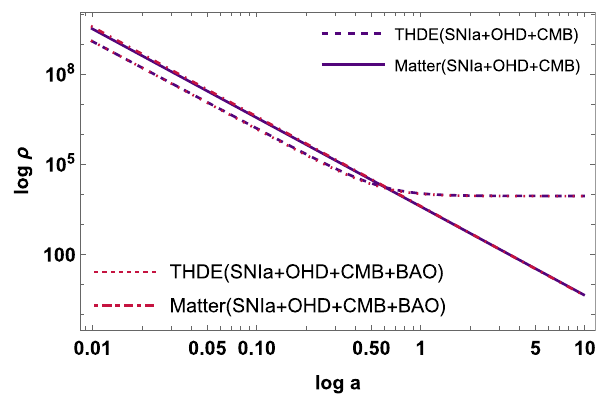
Fig. 5 Evolution of matter density and THDE density with scale factor of the universe in logarithmic scale using the fourth and sixth datasets